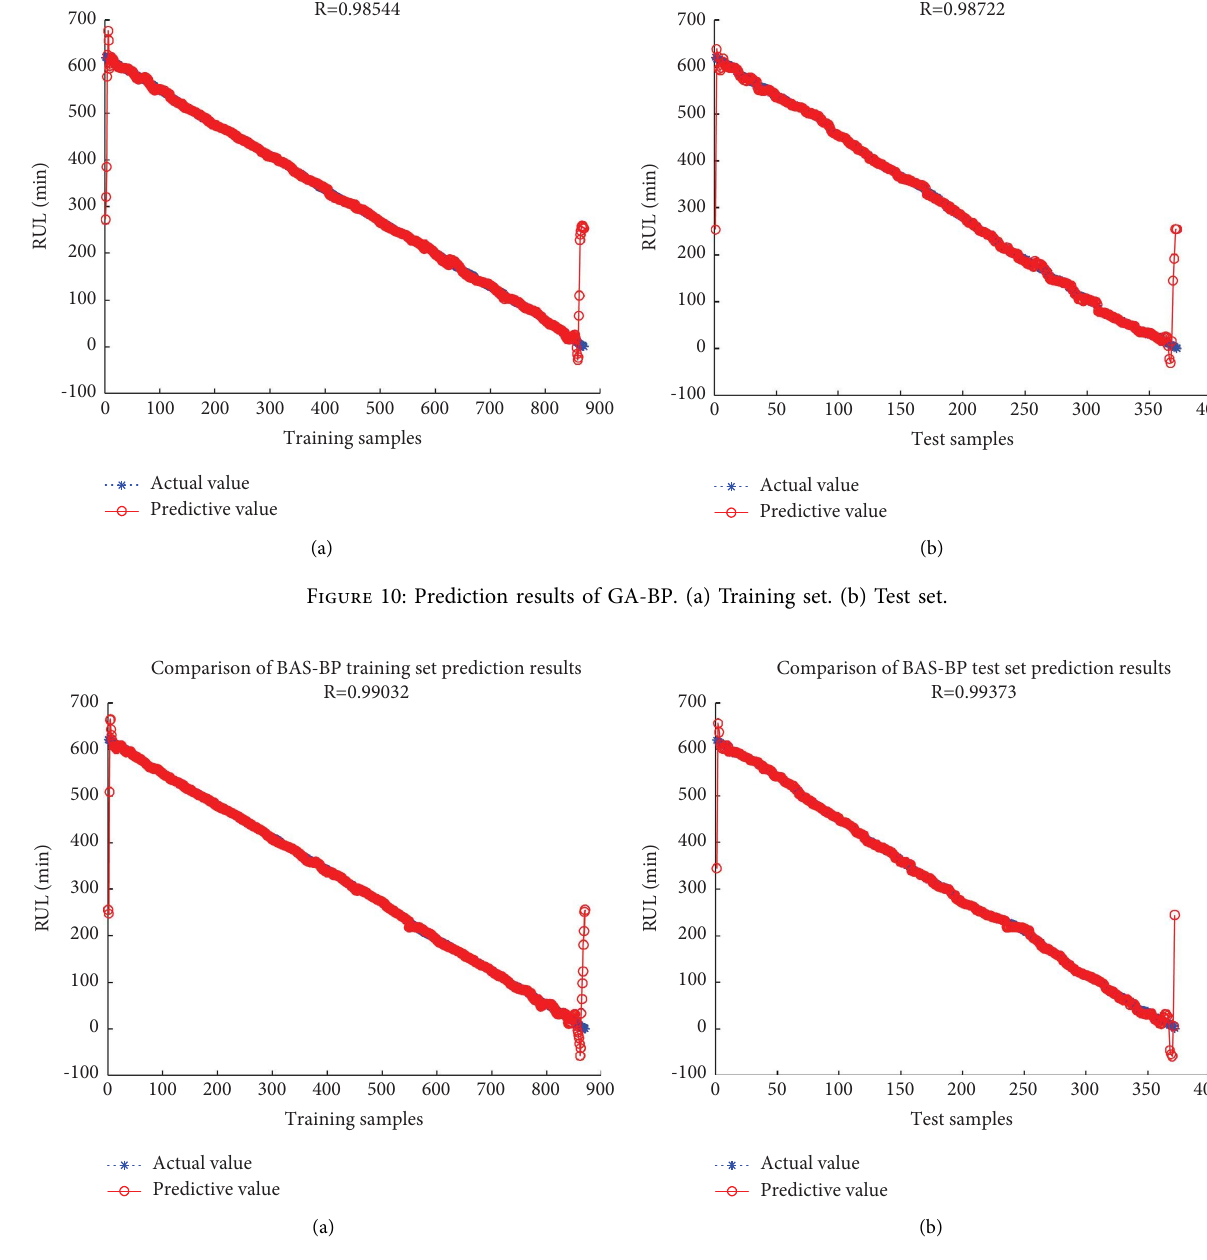
Figure 11: Prediction results of BAS-BP. (a) Training set. (b) Test